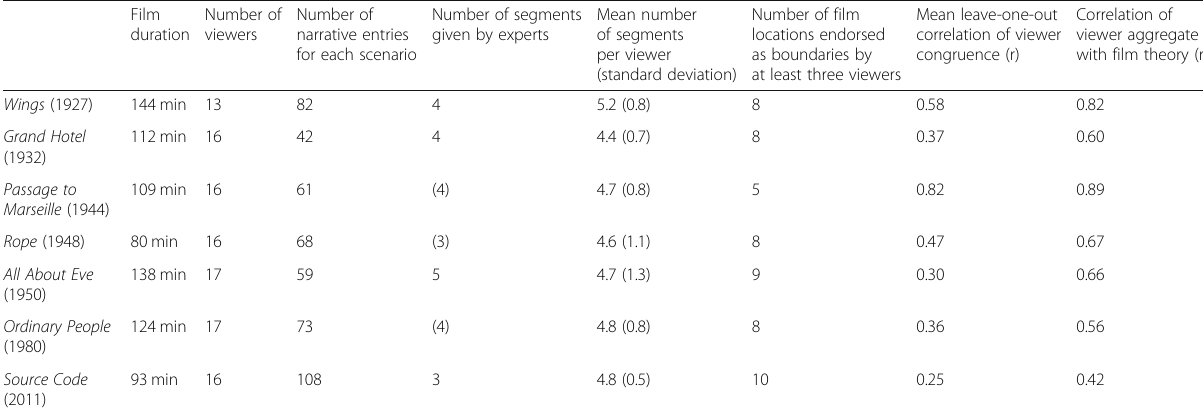
Table 1 Films and segmentation